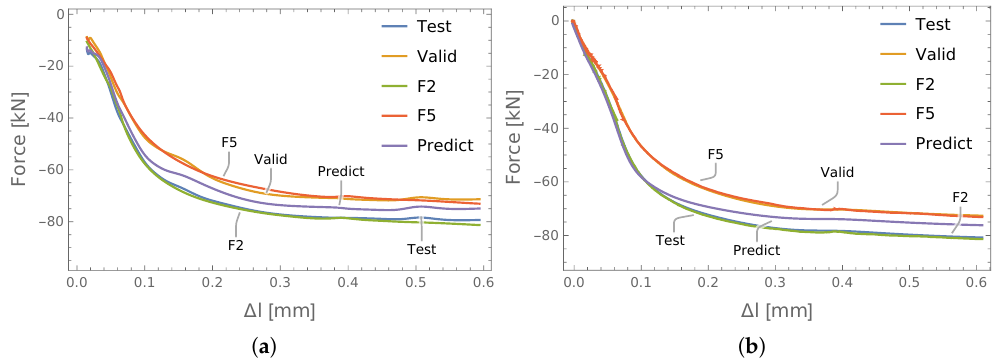
Figure 12. The results of force identification in the P3 connection based on: ( a ) load/elongation increments; ( b ) direct elongation of the bolt